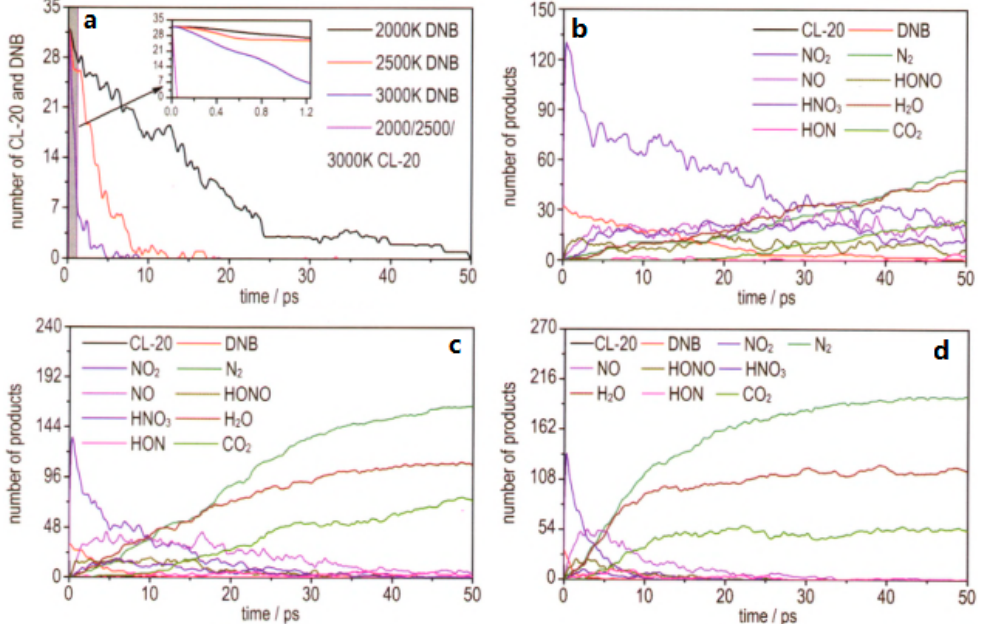
Figure 5. Time evolution of consumption of CL-20 and DNB and main products at various temperatures. ( a ) CL-20 and DNB; ( b ) 2000 K; ( c ) 2500 K; ( d ) 3000 K; [4], with permission from Han Neng Cai Liao, 2016.